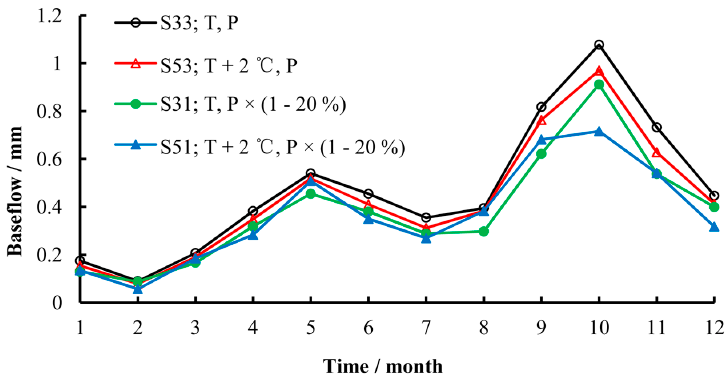
Figure 11. Distribution of monthly baseflow of S33, S53, S31, and S51 in the Lanhe Watershed.